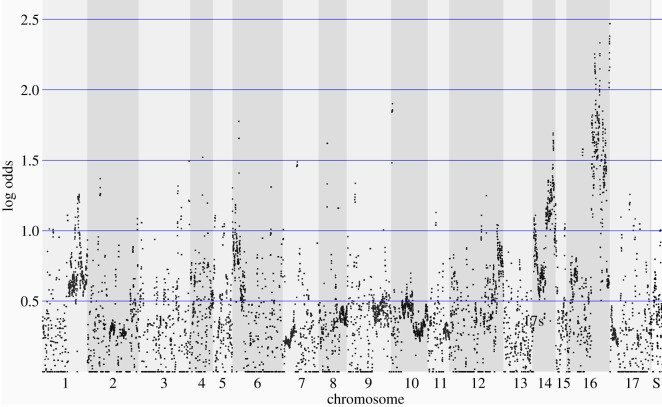
Results of bulked segregant analysis. Each point represents a non-synonymous SNP. Log odds reflect the probability of observing the estimated frequency difference (or greater) between the two pools by chance. ‘S’ refers to scaffolds not assembled into a chromosome.